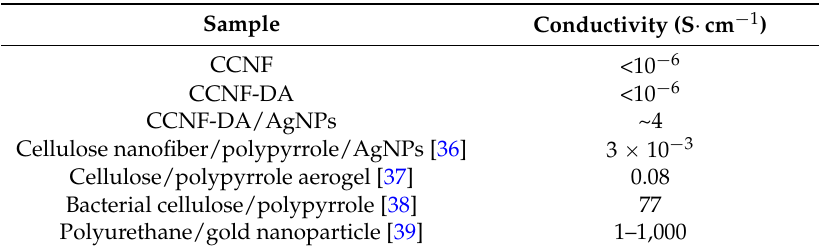
Table 1. Conductivity of CCNF, CCNF-DA and